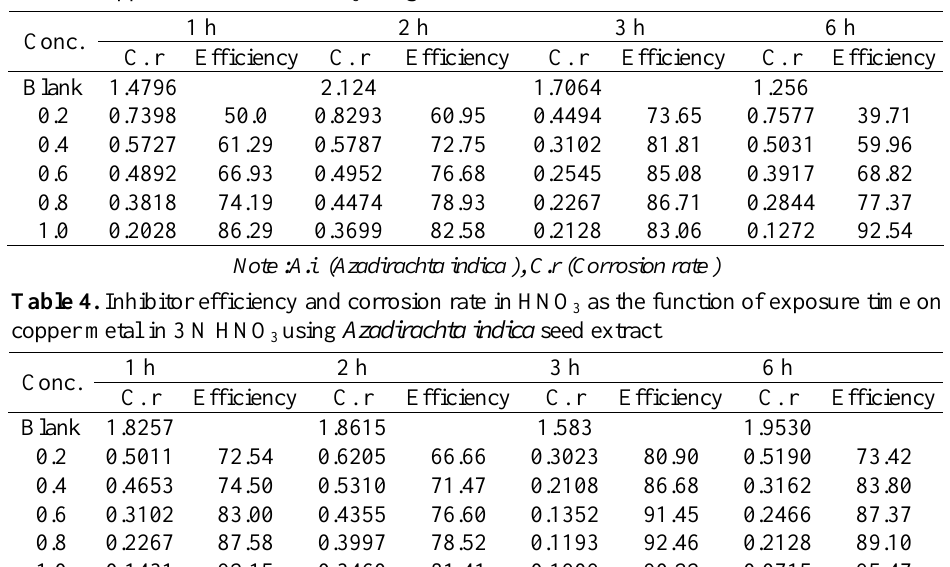
Table 3 . Inhibitor efficiency and corrosion rate in HNO time on copper metal in 2 N HNO